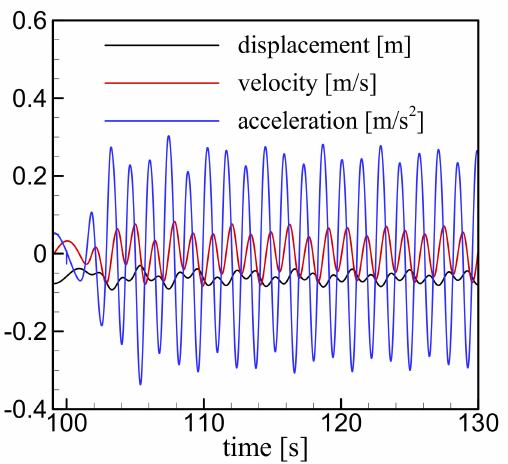
Figure 4. Surge displacement, velocity and